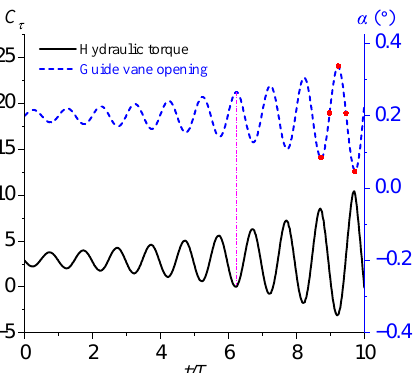
Figure 12. The time histories of the guide vane opening and total hydraulic torque in an unstable case ( α 0 = 0.2 ◦ and c ∗ e = 0.06%).